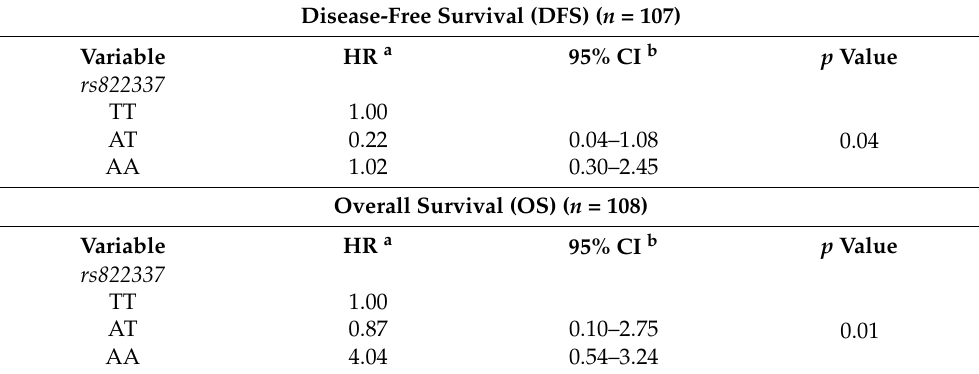
Table 4. Patient stratification based on the combination of the rs822336 G>C and rs822337 Τ > Α gen- otypes.